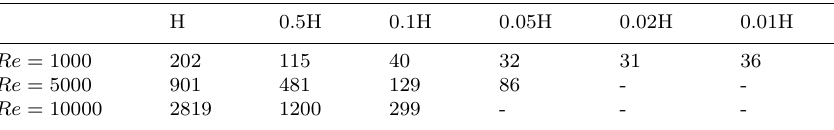
Table 4. Numbers of Oseen iterations by one-level subgrid stabilized method for lid-driven cavity flow with different stabilized parameter. H